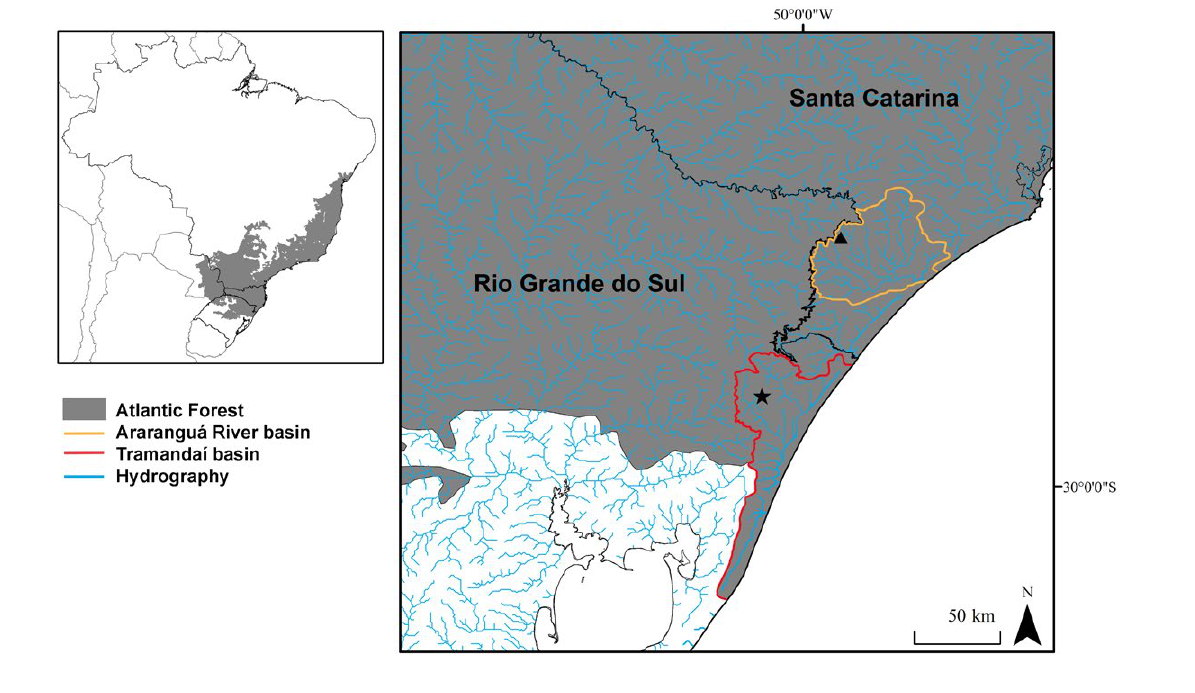
Figure 8. Distribution of Parastacus buckupi sp. nov. (star) and P. pilicarpus sp. nov. (triangle) in the states of Rio Grande do Sul and Santa Catarina, southern Brazil.